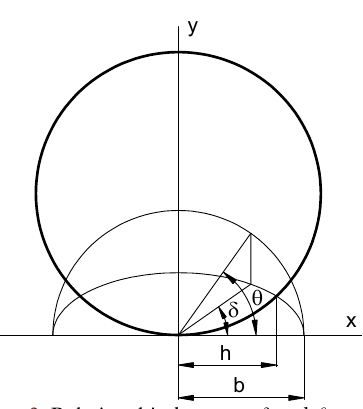
Figure 3: Relationship between δ and θ